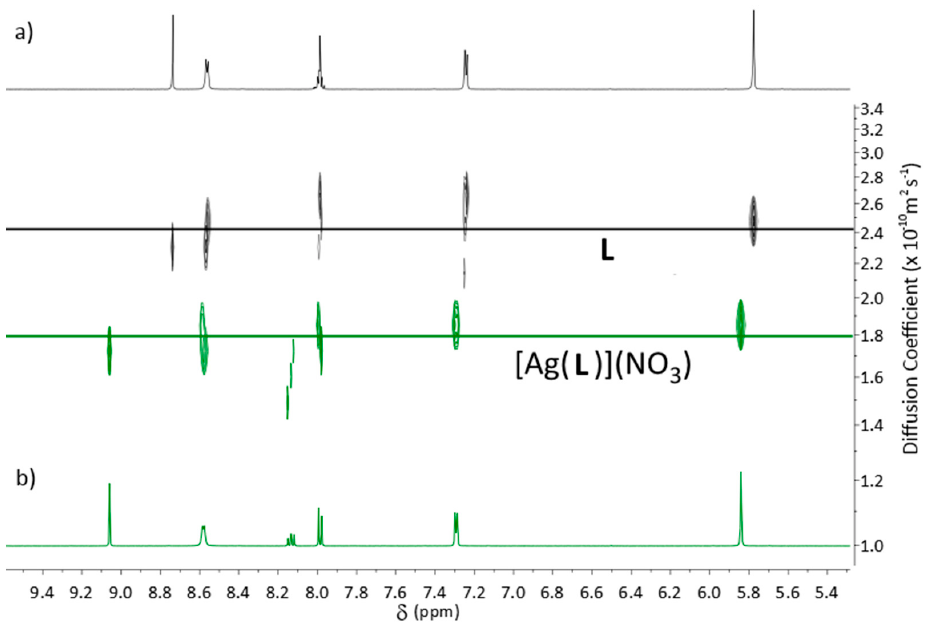
Figure 3. Partial stacked 1 H DOSY NMR spectra (500 MHz, d 6 -DMSO, 298 K) of ( a ) L (black trace), ( b ) [Ag( L )]NO 3 (green trace).